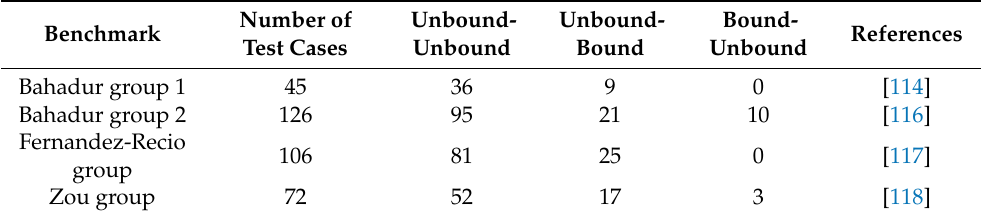
Table 3. List of RNP docking benchmarks. The number of unbound-unbound, unbound-bound and bound-unbound test cases is listed in this table.